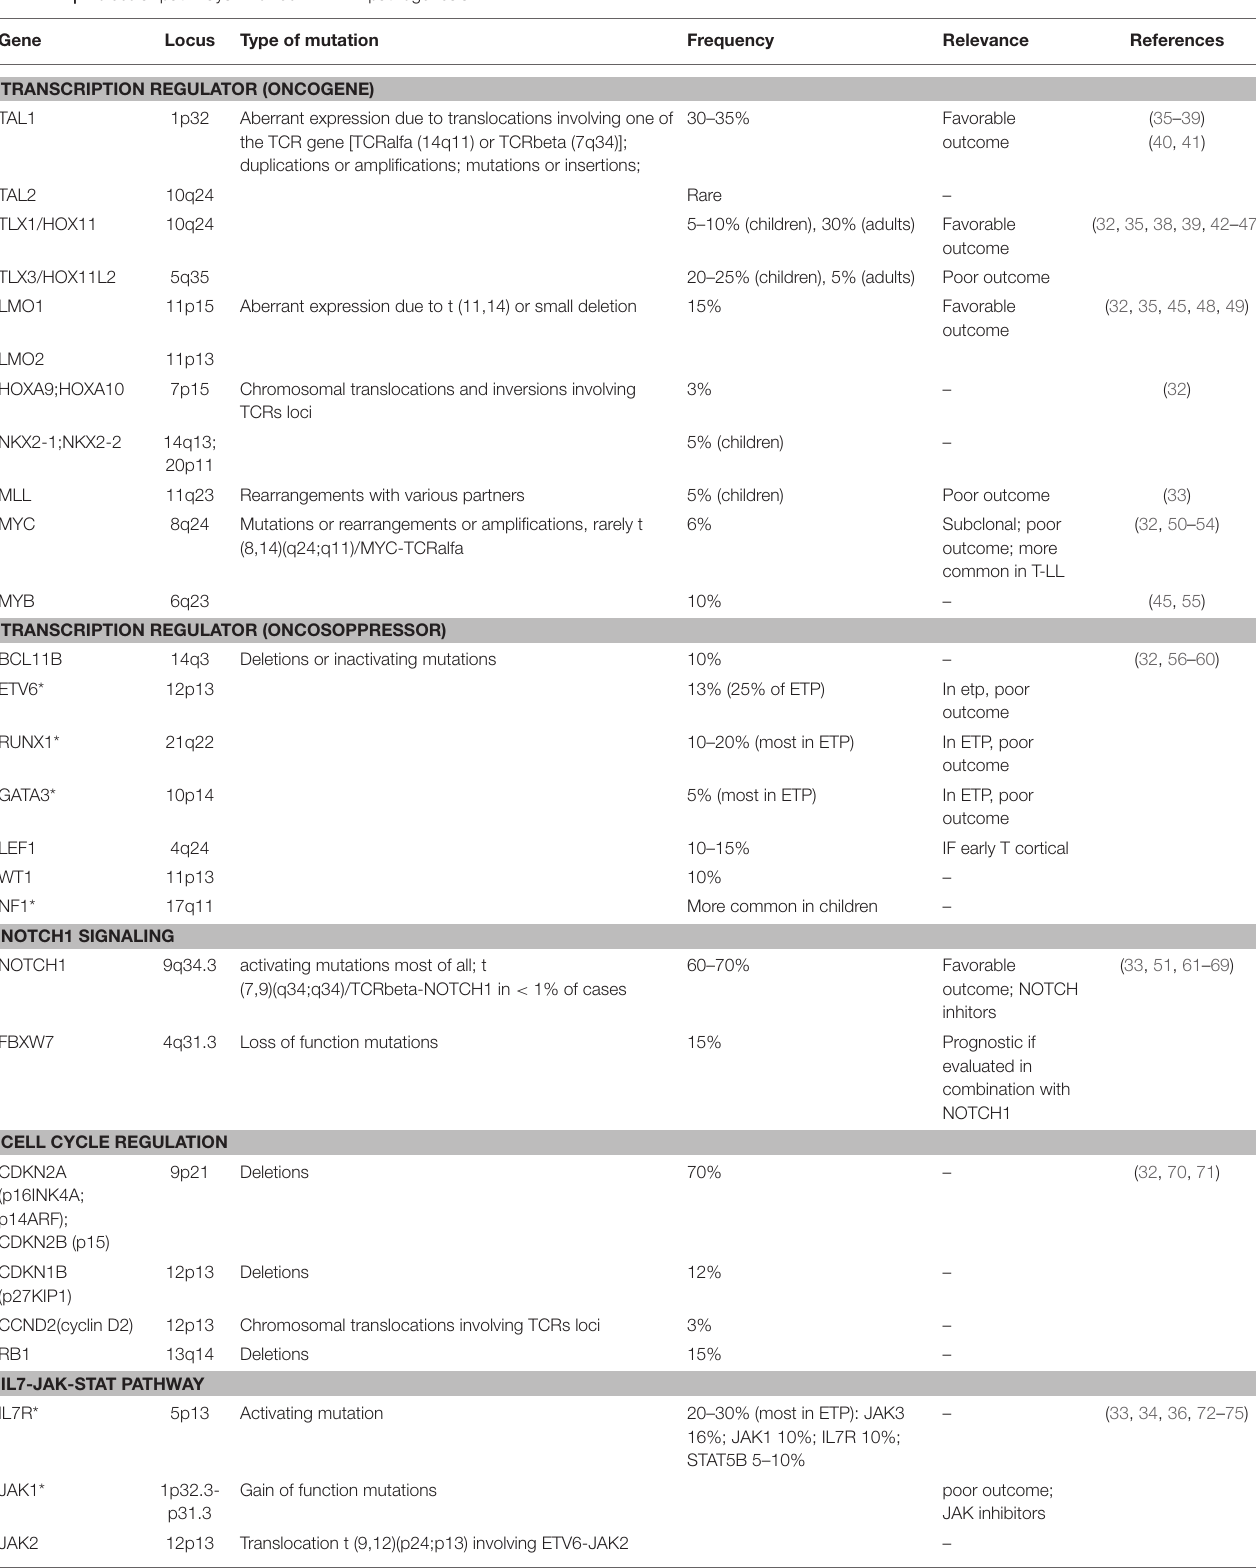
TABLE 1 | Molecular pathways involved in T-ALL